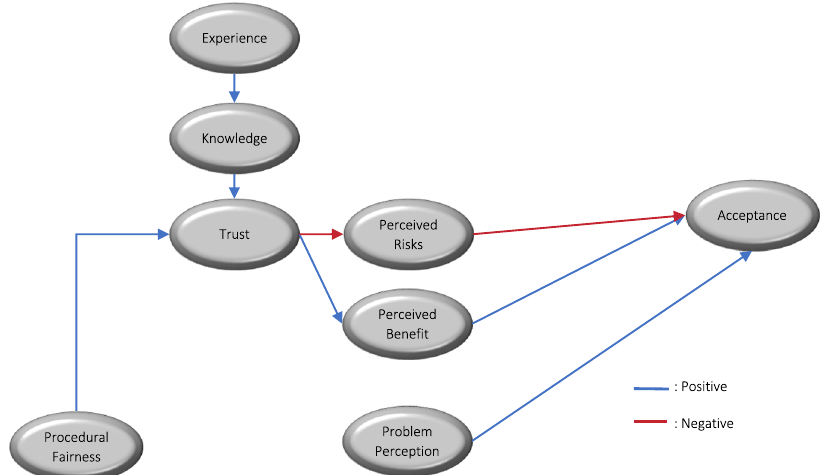
Fig. 6 Structural model results for the social acceptance of METU Forest in Ankara, Turkey. Insigni fi cant variables are dropped from the theoretical model. Arrows represent the direction of causality between the latent variables. The red and blue arrows represent negative and positive associations,